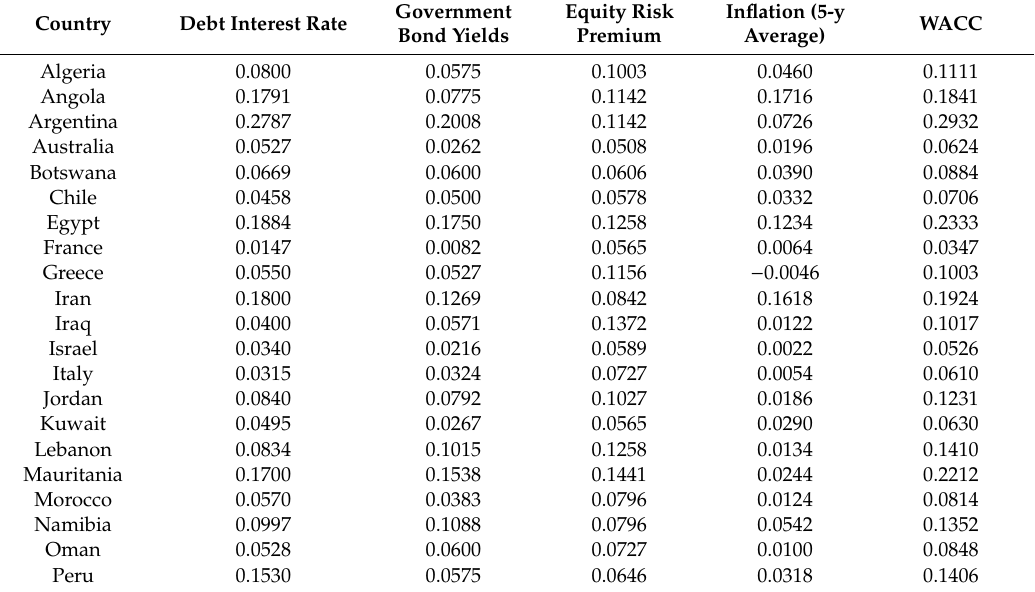
Table A2. Estimates for interest rates, inflation, and the nominal weighted average cost of capital